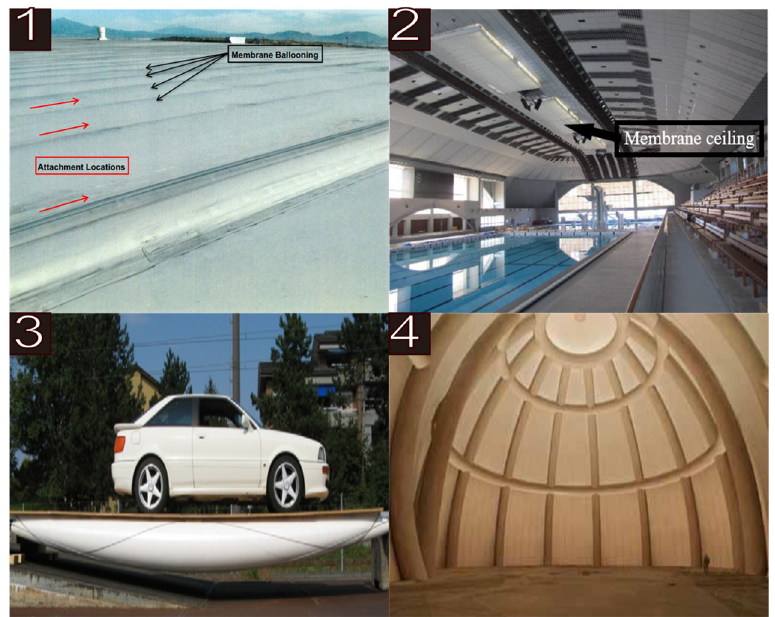
Figure 4. Other types of membrane structures: 1. Membrane roof, 2. Membrane ceiling, 3. Tensairity, 4. A movable laboratory [5,7,34,36].